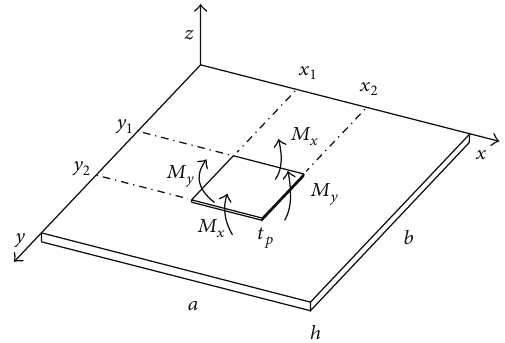
Figure 6: Plate structure with a